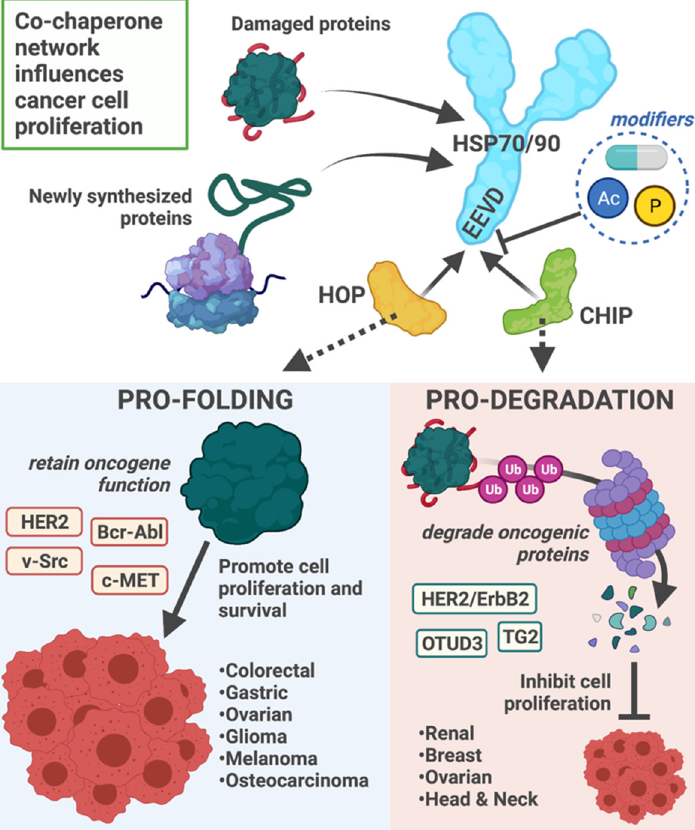
Figure 5. Co-chaperone network influences cancer cell proliferation. The decision to refold or degrade proteins represents an essential component of protein quality control. The co-chaperones HOP and CHIP compete for binding the EEVD motif located at the C-terminal tail of HSP70 and HSP90. The balance in HOP versus CHIP binding to HSPs results in a pro-folding or pro-degradation complex, respectively. In cancer, the pro-folding environment promotes cell proliferation by the constant re-folding of oncogenic proteins. In contrast, if CHIP–HSP binding is favored, oncogenic proteins can be degraded through the ubiquitin-proteasome system and ultimately inhibit cell proliferation. The cancers associated with these protein environments and identified substrates are provided. Additionally, the affinity of HOP and CHIP to HSPs are modified by post-translational modifications, including phosphorylation (P) and acetylation (Ac). Likewise, small molecules that target the C-terminus of HSP70 and HSP90 may influence co-chaperone occupancy. The C-terminal tail of HSP70/90 and post-translational modifications could be targeted to control the protein triage environment. Table 1. CHIP function in different cancers.